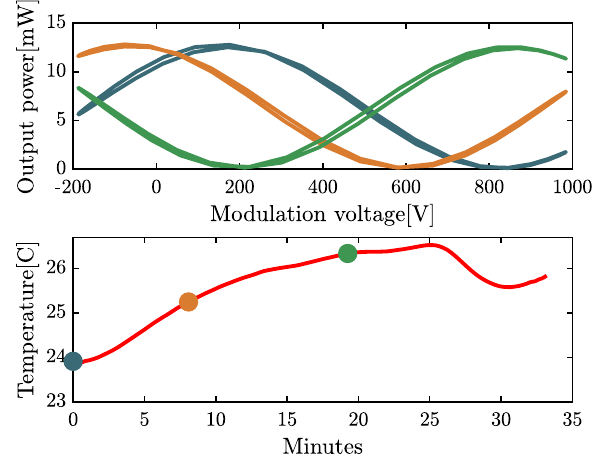
Figure 22. Shift of the transfer function due to rising temperature.